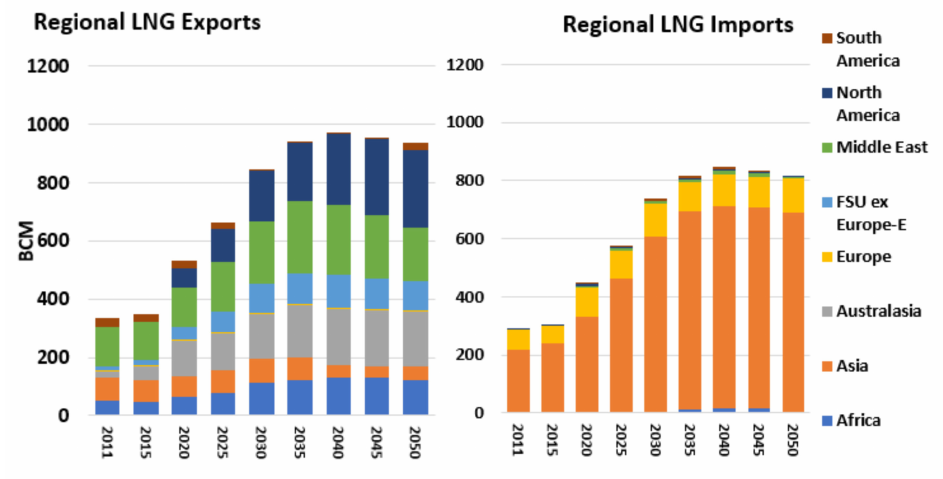
Figure 21. Global LNG exports and